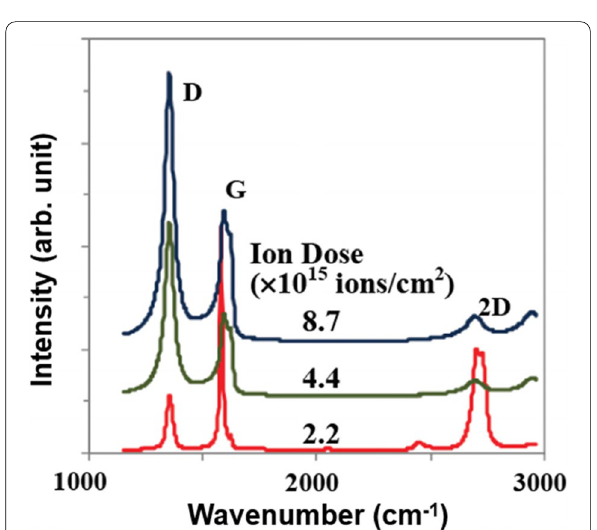
Fig. 6 Raman spectra of graphene films subjected to varying helium ion doses. Although the intensity of the D band was increased by helium ion irradiation, there was no significant change in the G band, indicating that defects were generated, while the honeycomb framework was well maintained. Figure modified from